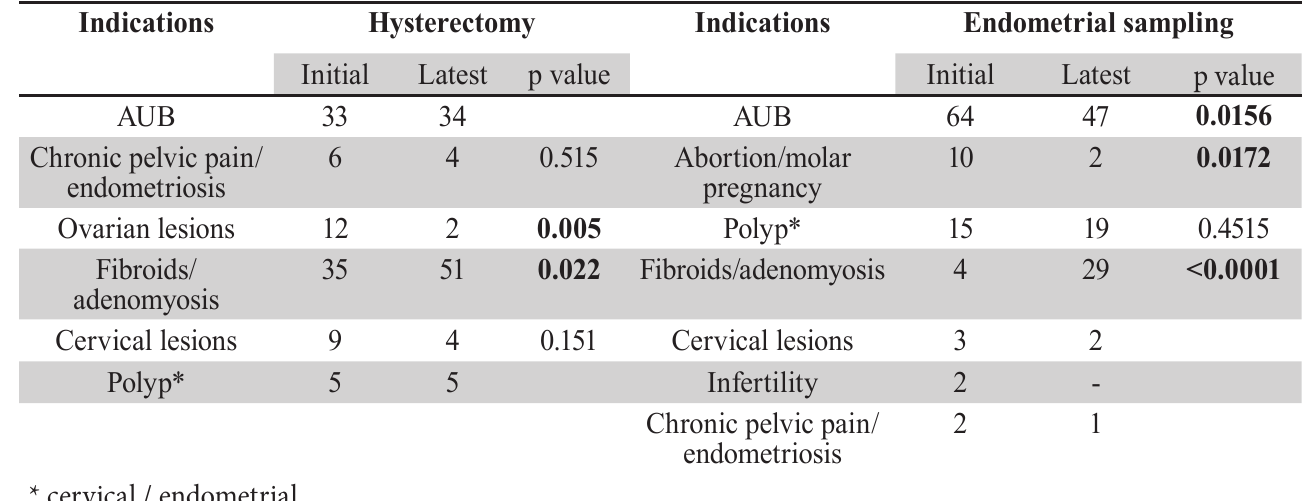
Other districts Table 3: Indication of open and laparoscopic hysterectomies and endometrial sampling Indications